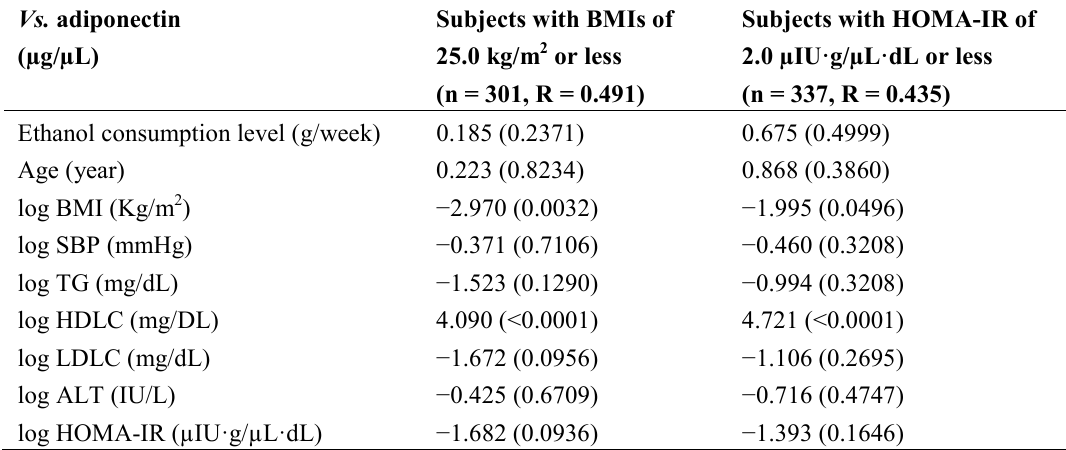
Table 5. Relationship between levels of serum adiponectin and ethanol consumption assessed by multiple regression analyses in subjects without insulin resistance or obesity; t value (p